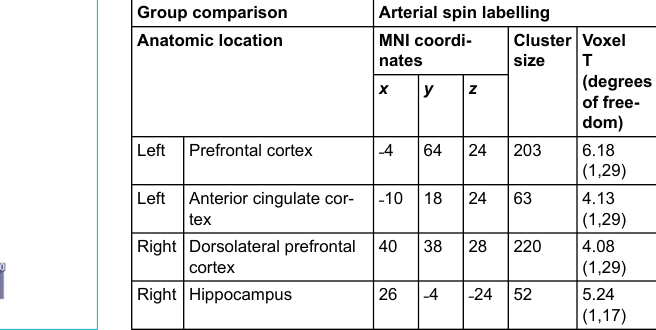
Table 1: Main findings after 12 weeks of treatment in the responder and nonresponder groups. Group